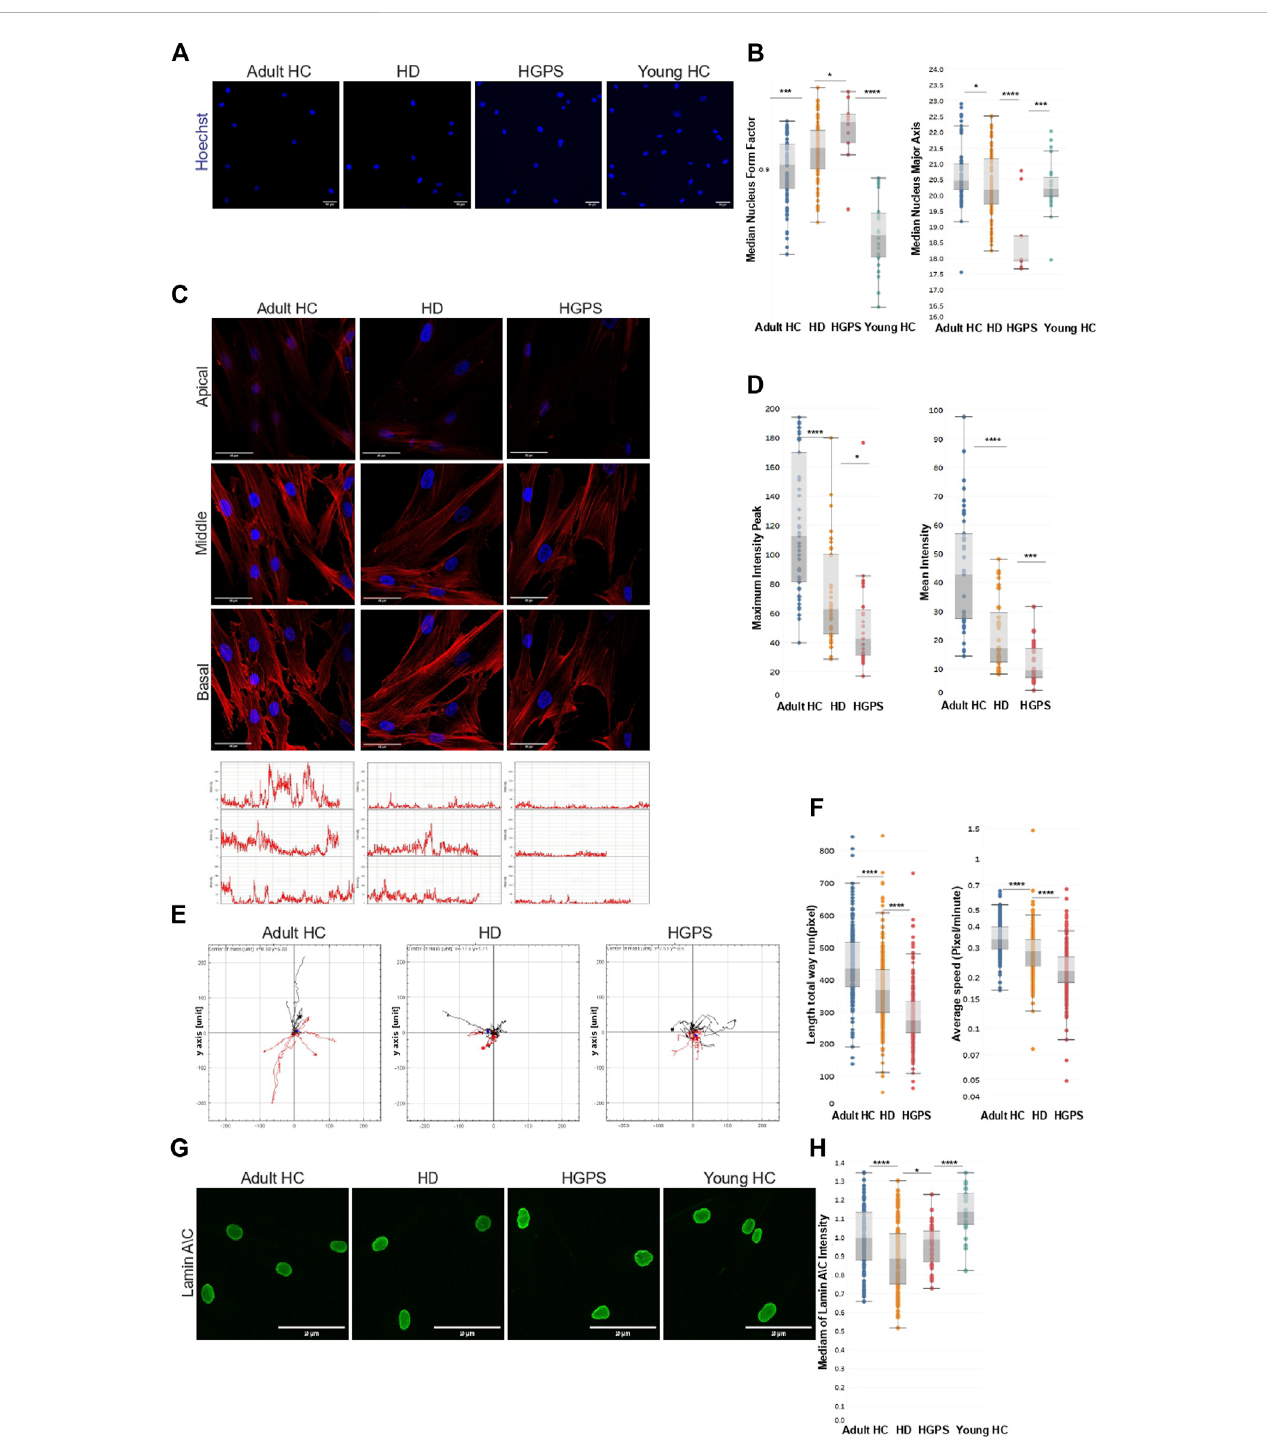
FIGURE 2 Actin Cap in HD skin fi broblast cells (A) Representative images of fi xed primary skin fi broblast cells of Adult HC, HD, HGPS, and young HC cells stained with Hoechst to label the cell nuclei and phalloidin to label F-actin, acquired with a 20x magni fi cation using INCell 2200 image analyzer. Scale bar = 50 µm. Cells of indicated groups were segmented automatically using the INCell Developer toolbox software. (B) Mann-Whitney ’ s U test was performed on the mediansofthenuclearformfactorandnuclearmajoraxisperwell(11HC,12HD,5HGPS,4youngHC),~500cellsfromeachskin fi broblastsampleusing GraphPad 8; the results are presented in box plots using Tableau 2020.3. (C) On the upper panel representative confocal immuno fl uorescence staining images ofHD,HC,and HGPSskin fi broblast cellsof3z-stacks(Basal,Middle,Apical)showinglessactin fi lamentsintheapical surfaceoftheHDandtheHGPS fi broblastcells.Skin fi broblastcellimageswereacquiredwitha40xmagni fi cationusingLeicaSP8confocalmicroscope.Scalebar=50 μ m.Cellswerestained with Hoechst to label the cell nuclei and phalloidin to label F-actin of fi xed cells. On the lower panel representative intensity graphs of actin in the apical z-stack, each graph represents one nucleus, Y-axis represents intensity levels (0 – 250), X-axis represents pixels. (D) Mann-Whitney ’ s U testwas performed on the medians of the mean intensity of actin fi bers, and of the maximum peak of different actin intensity graphs in the apical z-stack of ~20 cells from each skin fi broblast sample (2 HC, 2 HD, 2 HGPS) showing signi fi cant lower measurements in the two parameters in HD and HGPS samples. (E) Single-cell random